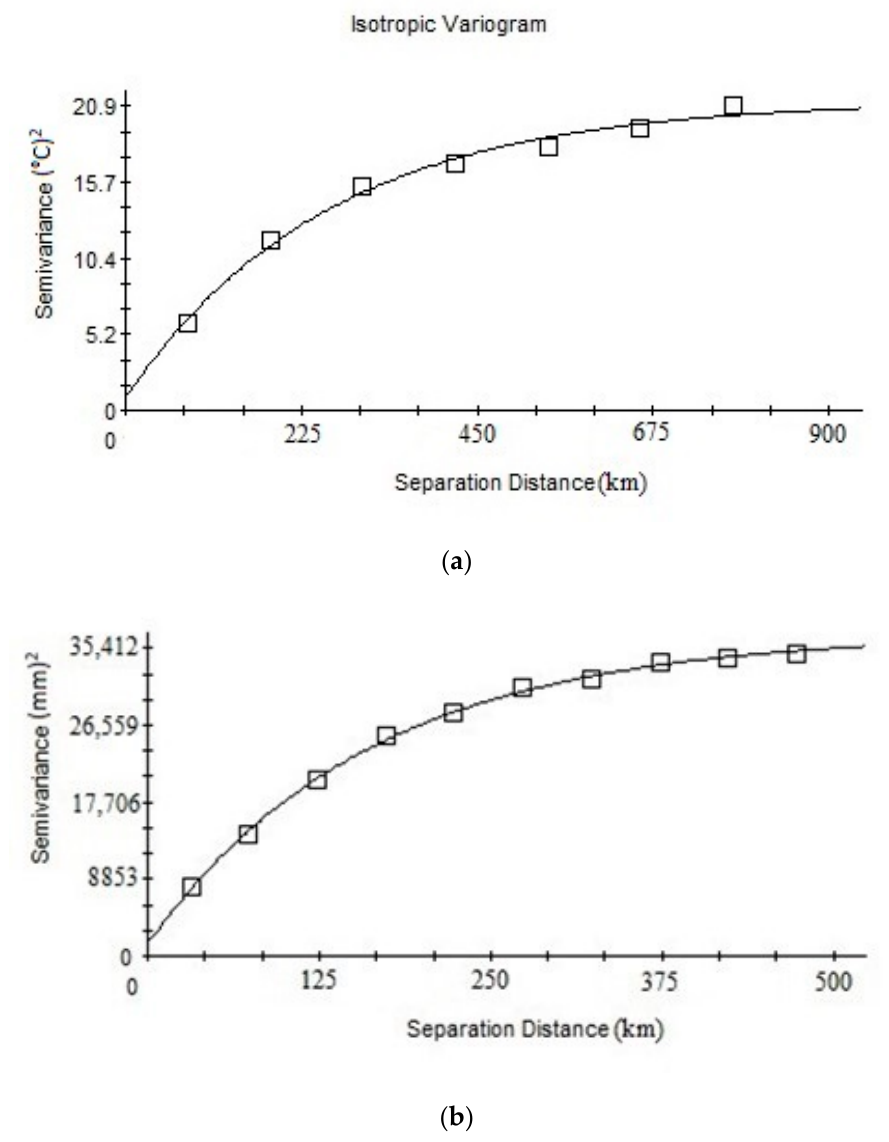
Figure 3. Semi-variogram of the annual mean temperature ( a ) and annual average precipitation ( b ). Table 2. Components of the best optimum semi-variogram model fitted to the two studied